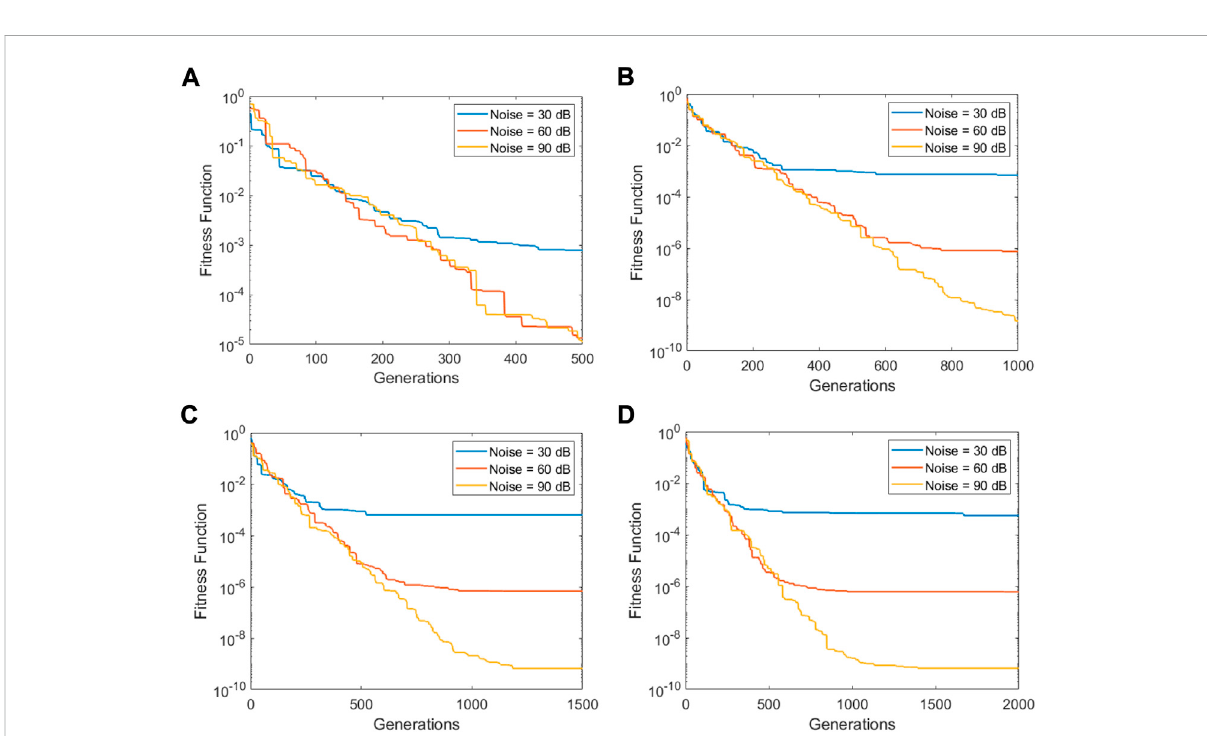
FIGURE 3 Convergence plots of Example 1: (A) G = 500, (B) G = 500, (C) G = 500, and (D) G =